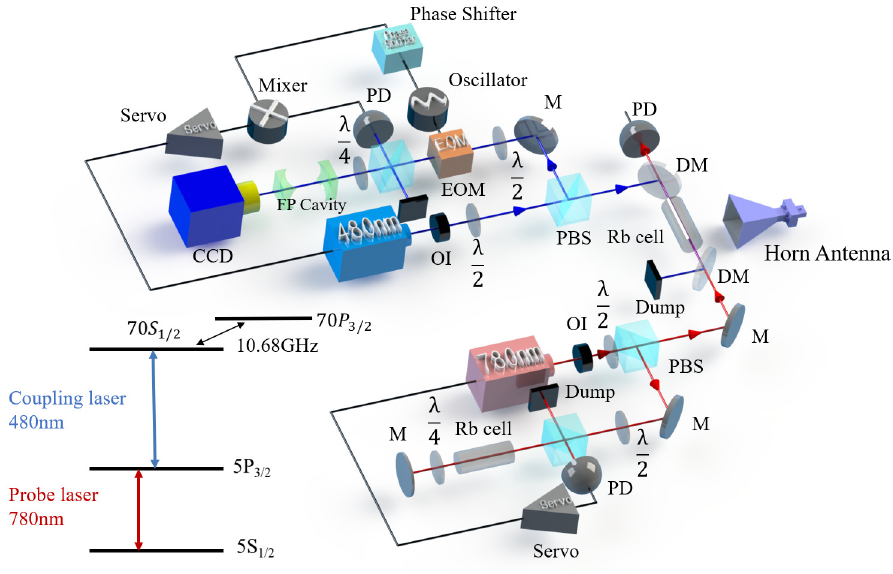
Figure 1. Experimental setup and its concerned four-energy-level diagram. The coupling ( λ c = 480 nm) and probe ( λ p = 780 nm) beams counter-propagate through a Rb vapor cell, forming a ladder-type EIT with upper Rydberg states coupled further by microwave RF. It is emitted by a horn antenna, serving as a local RF electric field oscillator (LO). The probe beam passing through an Rb cell and a dichroic mirror (DM) is detected by a photodiode (PD). The probe beam is frequency-locked to | 5 2 S 1/2 ,F = 3 (cid:105) → | 5 2 P 3/2 ,F = 3 (cid:105) transition via an integrated saturated absorption spectroscopy (SAS) unit of 85 Rb atoms. The coupling beam scans across transition | 5 2 P 3/2 (cid:105) → | 70 2 S 1/2 (cid:105) and can also be frequency-locked to this transition via a Pound-Drever-Hall technique (PDH) based on an ultra-stable cavity on